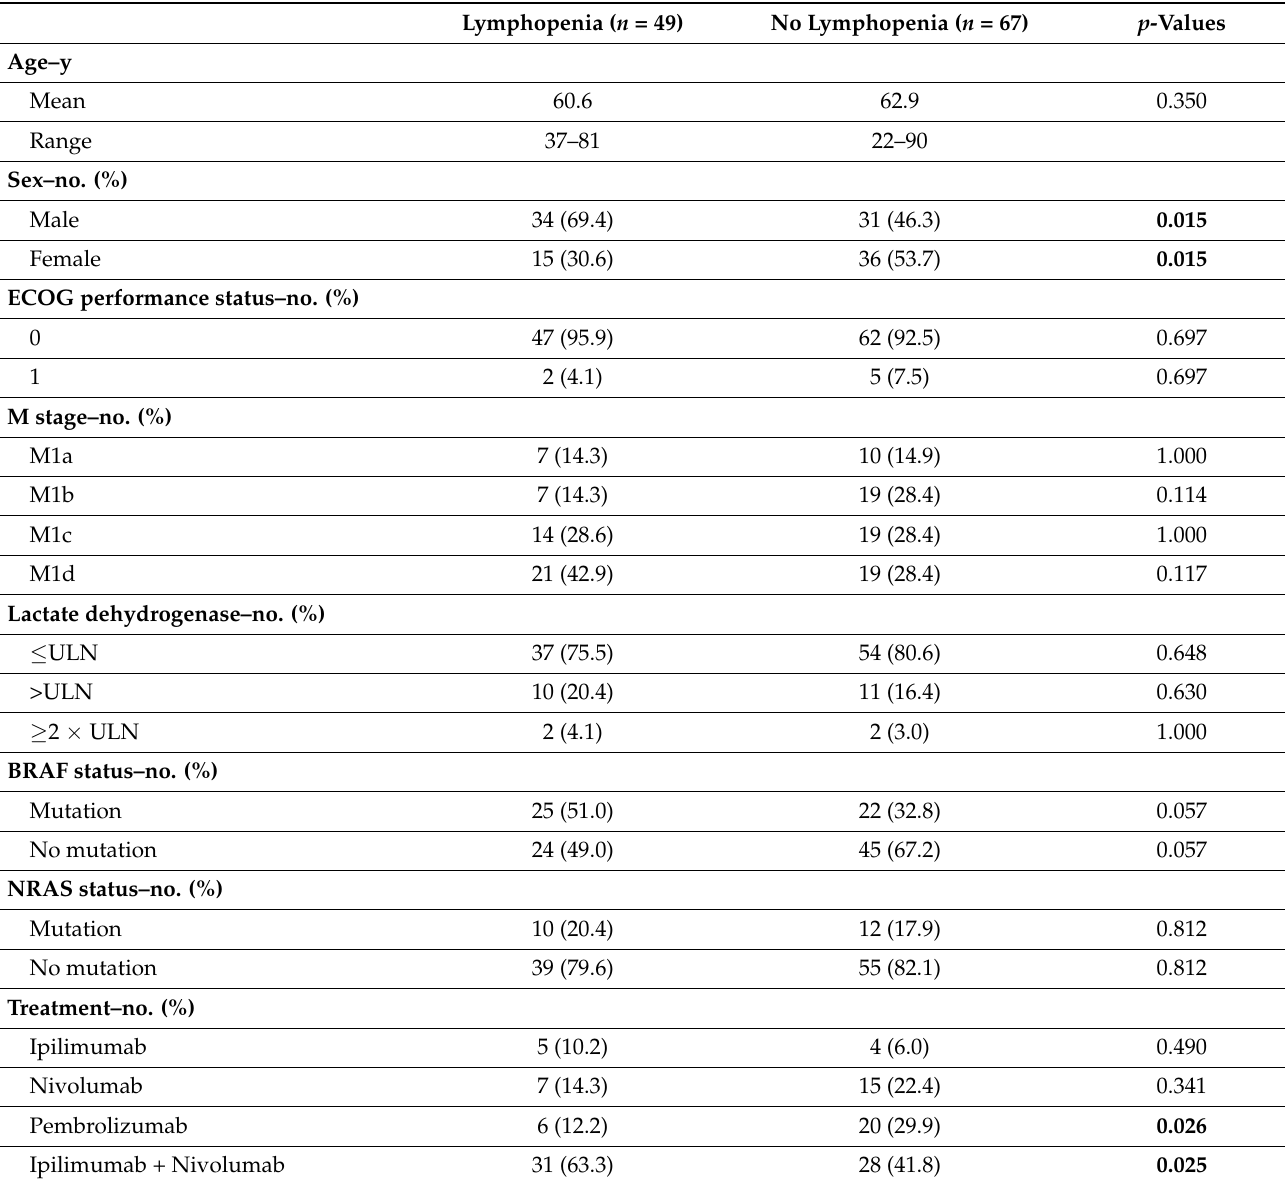
Table 1. Baseline characteristics of the patients. Percentages are given in